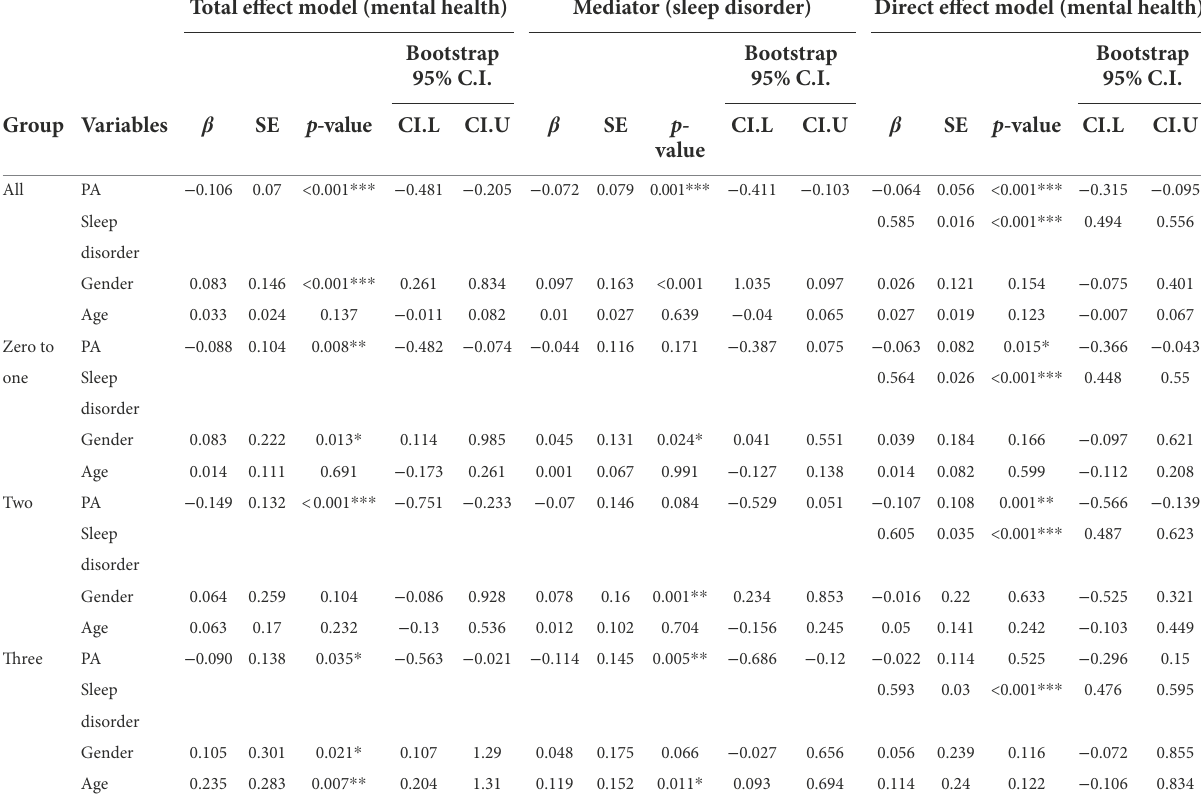
TABLE 3 Mediation analyzes: association between physical activity and mental health via sleep disorder.